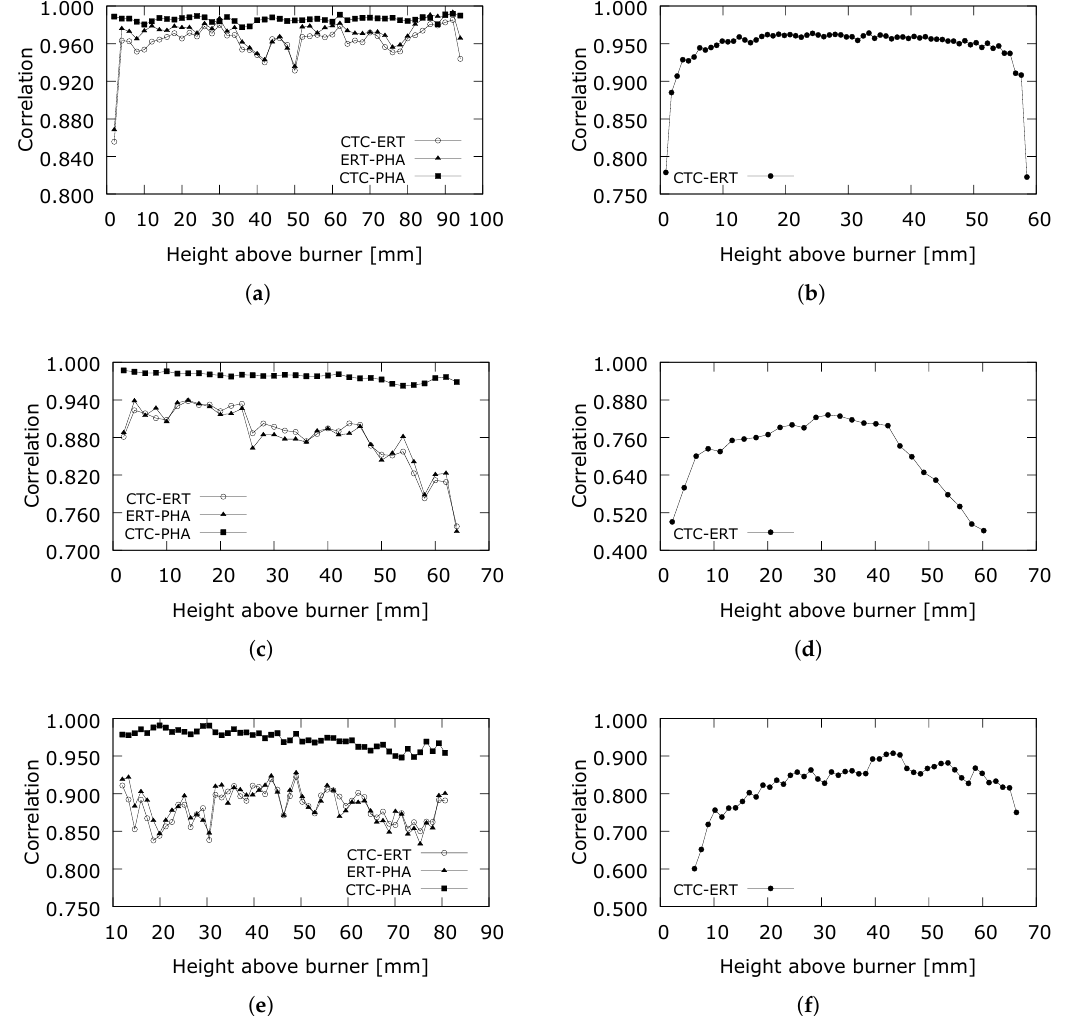
Figure 16. Calculated correlations based on horizontal slices. ( a ) Bunsen flame phantom; ( b ) Bunsen flame experiment; ( c ) Swirl flame phantom; ( d ) Swirl flame experiment; ( e ) Cambridge-Sandia stratified flame phantom; ( f ) Cambridge–Sandia stratified flame